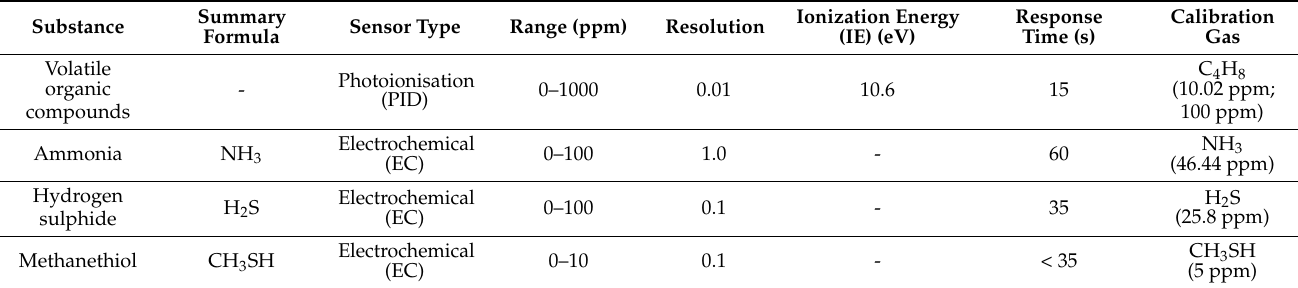
Table 5. Characteristics of the MultiRAE Pro gas detector